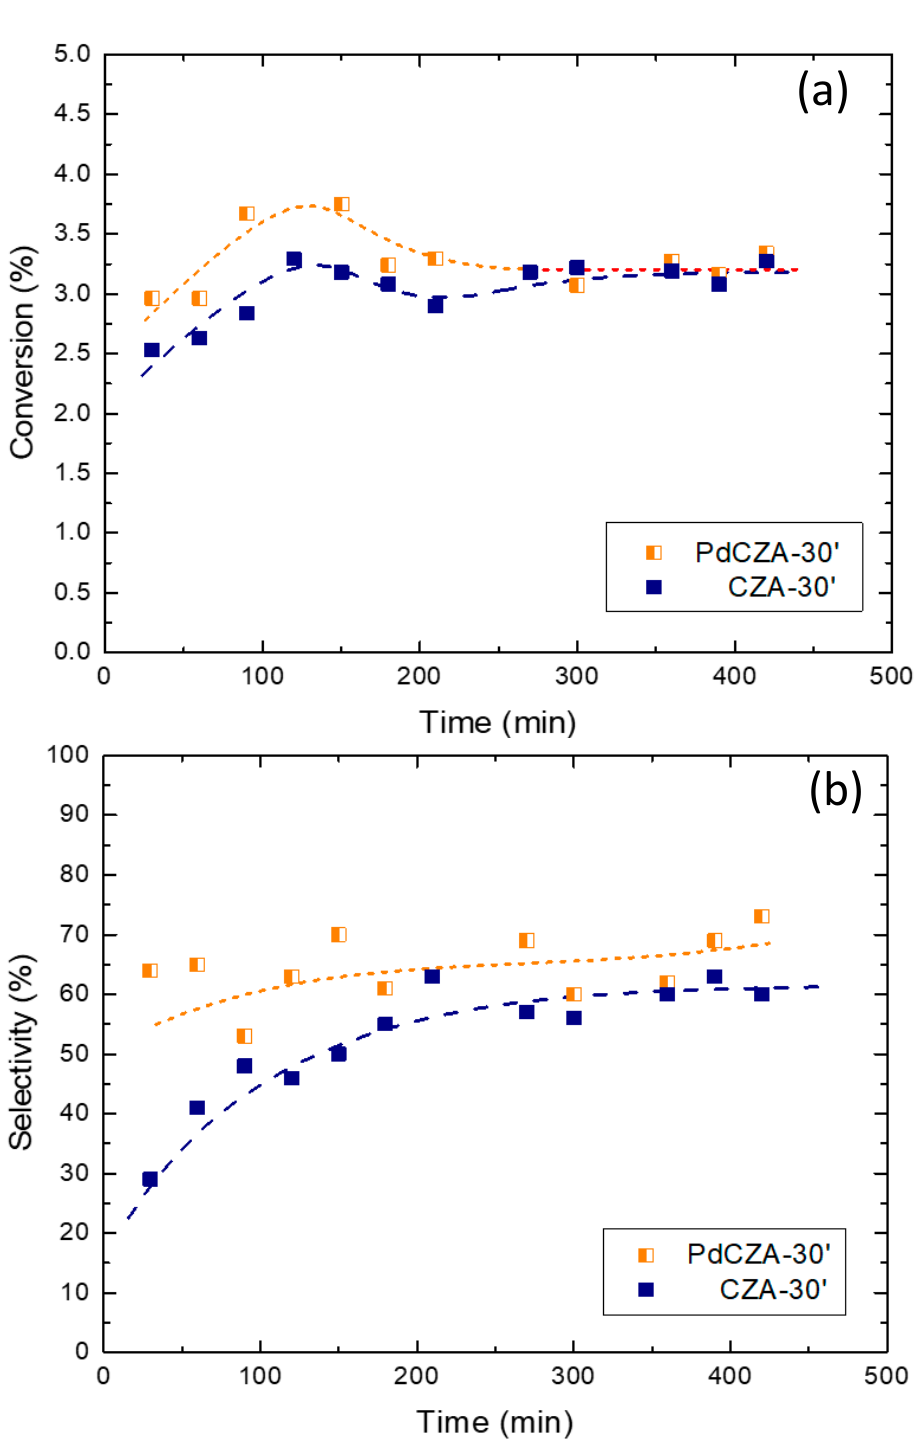
Figure 8. ( a ) Conversion and ( b ) selectivity for PdCZA-30 (cid:48) and CZA-30 (cid:48) at 5 bar and 210 ◦ C. At 210 ◦ C, CZA-30 (cid:48) selectivity had a value ca. 55% and PdCZA-30 (cid:48) of 63.4% with